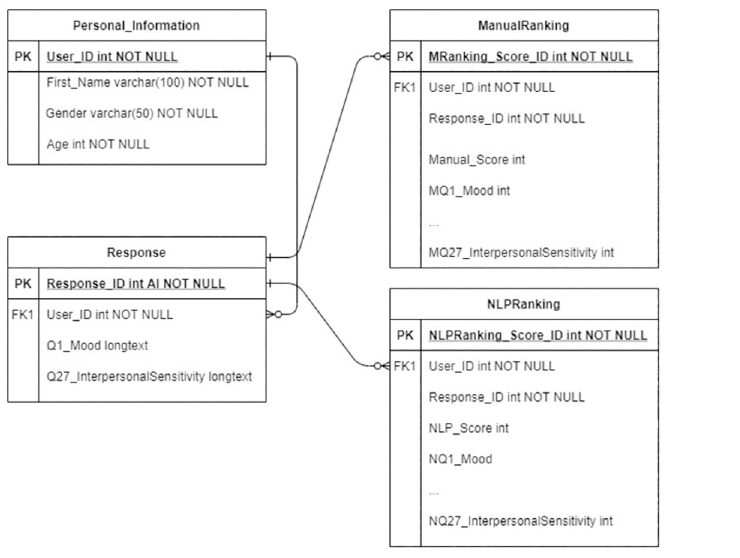
Fig 3. Schema/E-R diagram of the central database.